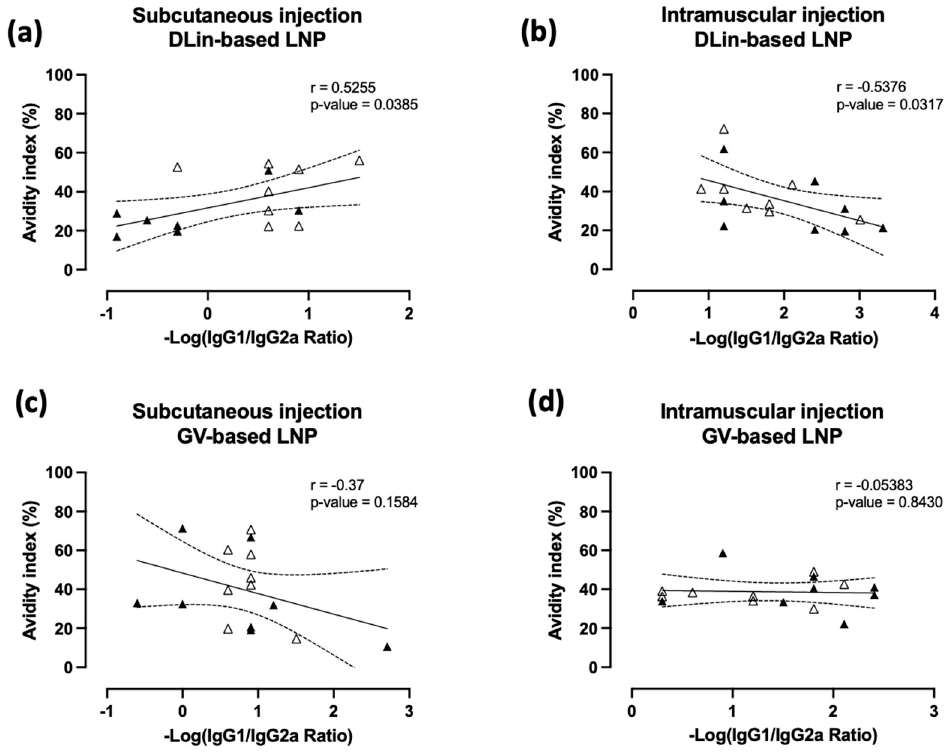
Figure 5. DLin-based LNPs showed opposite effects in a delivery route-dependent manner. The correlation between IgG1/IgG2a ratios and avidity indices obtained in DLin-LNP ( a , b ) and GV-LNP ( c , d ) treated mice after SC ( a , c ) and IM ( b , d ) injections. Data from weeks +10/+14 were used to determinate relations between IgG1/IgG2a ratios and avidity indices during mRNA protein immunization schedule. Each data point represents an individual animal before (black triangle) and after (white triangle) protein boost. For each formulation and delivery route, statistical analysis was performed to construct the correlation curve and 95% confidence index (continuous and dotted lines, respectively). The Spearman or Pearson correlation test was applied to determine the linear correlation coefficient (r) and its associated p -value ( p < 0.05: not significant; p > 0.05: significant). When DLin-LNPs were initially injected (Figure 5a,b), before the protein boost,